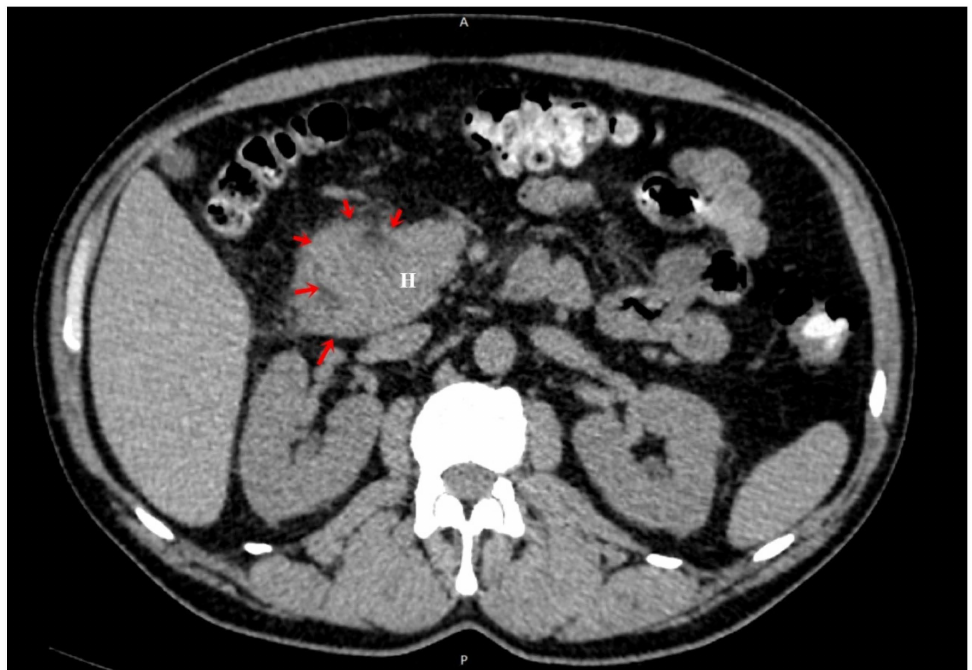
Figure 2. Unenhanced abdominal CT, axial plane focused on duodenum (D1–D2 segments) and pancreatic head (H) showing moderate mural thickening without delimitation from each other (red arrows). No signs of chronic pancreatitis. (A) Anterior part of the patient. (P) Posterior part of the